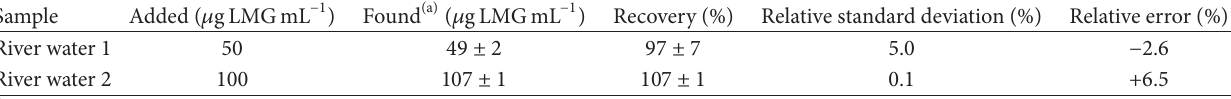
F 6: Double-channel FIA assembly with phosphate buffer carrier (a) and the effect of loop (b) and �ow rate (c) in the dispersion, percentage steady state, and sampling rate of the reported signals. Samples/standards are prepared in water. T 3: Potentiometric determination of LMG in river water using MAA/MIP-based membrane